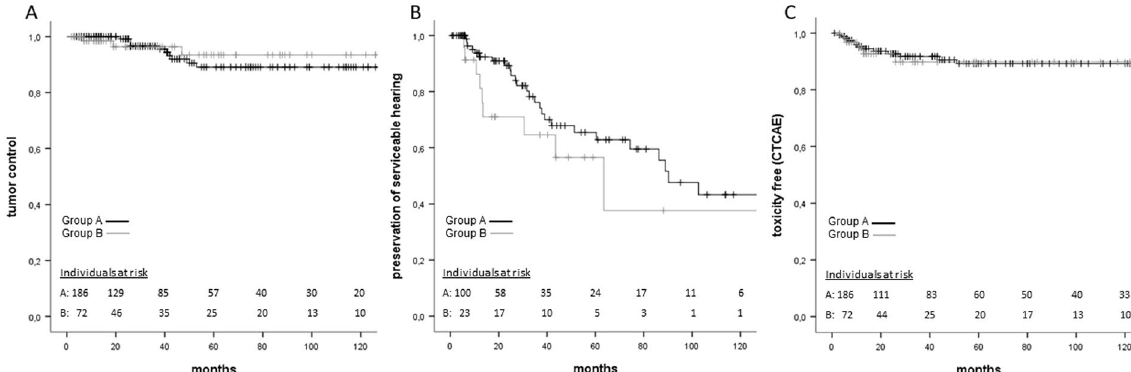
Figure 2. (A) Kaplan-Meier analysis of actuarial tumor control after SRS of unilateral VS for group A (Koos grade I/II) and B (Koos grades III/IV). There was no significant difference (logrank, p = 0.632) between either group. ( B ) Kaplan-Meier analysis of hearing preservation rate between group A and B. Log rank test and multivariate analysis revealed no statistically significant impact (logrank, p = 0.231) on hearing preservation rate. ( C ) Toxicity free survival in terms of permanent CTCAE showed no statistically significant difference in a logrank test (p = 0.93).